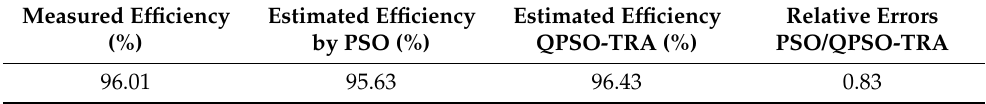
Table 6. Measured versus estimated efficiencies of the motors by PSO and QPSO-TRA methods. Measured Efficiency Estimated Efficiency (%) by PSO